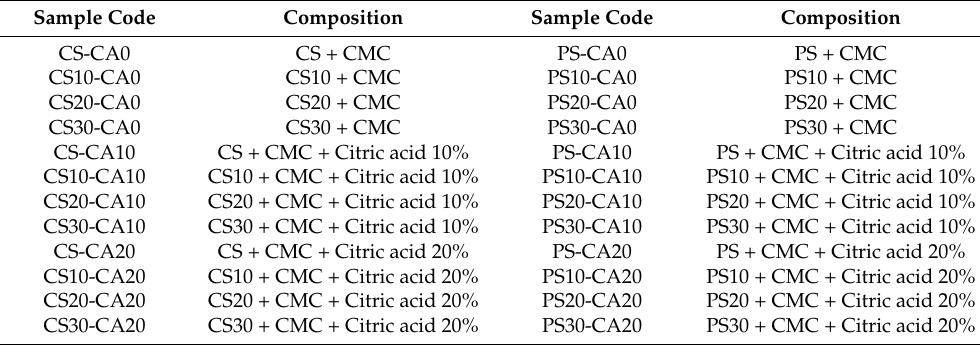
Table 2. The ingredient compositions that were used to prepare polysaccharide-based superabsorbent polymers